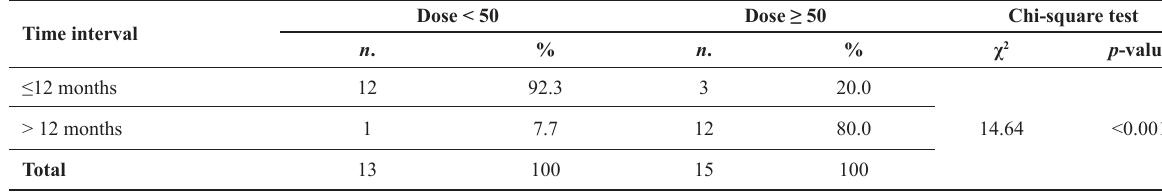
Table 3: Correlation between reirradiation dose and time interval